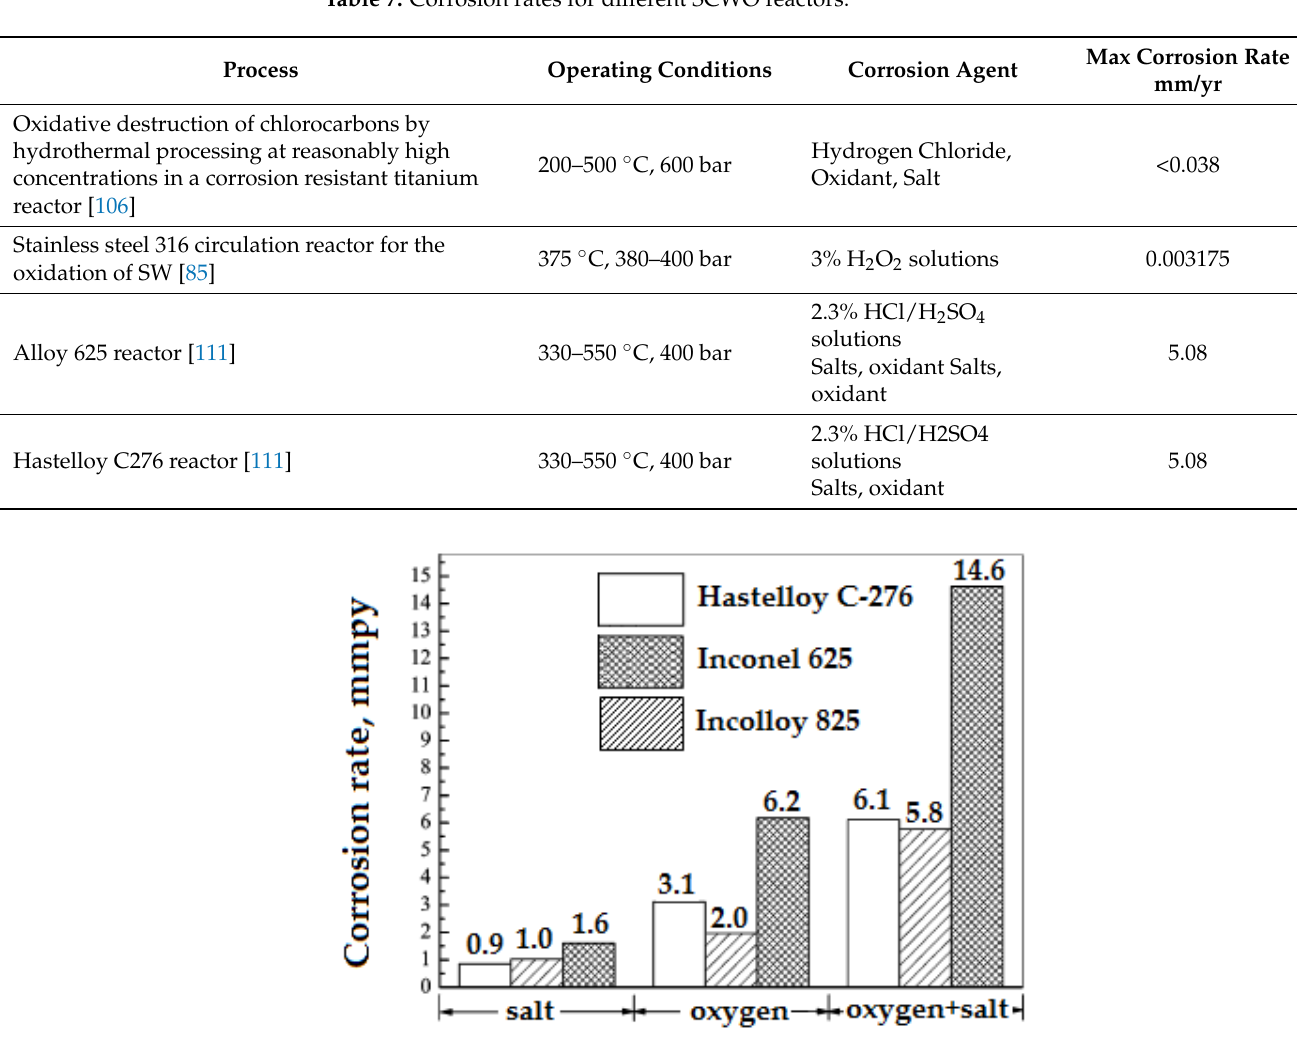
Figure 18. Effects of nickel-based alloys on the corrosion resistance [110].